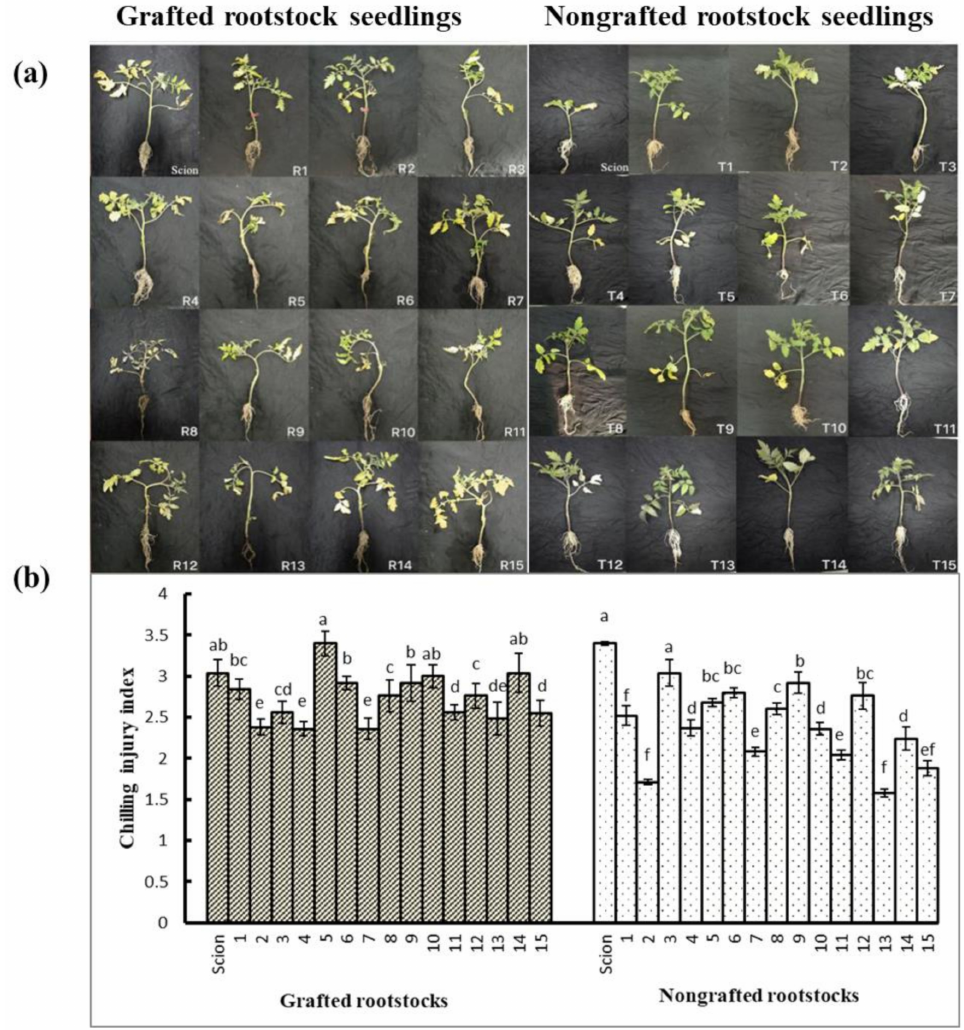
Figure 3. The low-temperature injury of grafted tomato seedlings (R1–R15) and nongrafted rootstock seedlings (T1–T15) under low-temperature stress: ( a ) indicates low-temperature injury symptoms; ( b ) chilling injury index. The nongrafted “Mingzhi88” was used as a control. The chilling injury index was determined at 12 days after low-temperature treatment (mean ± SEs), with 30 seedlings for each triplicate. The results are the mean ± SEs. The means within each column followed by different letters were significantly different among graft combination treatments, according to Tukey’s test ( p <